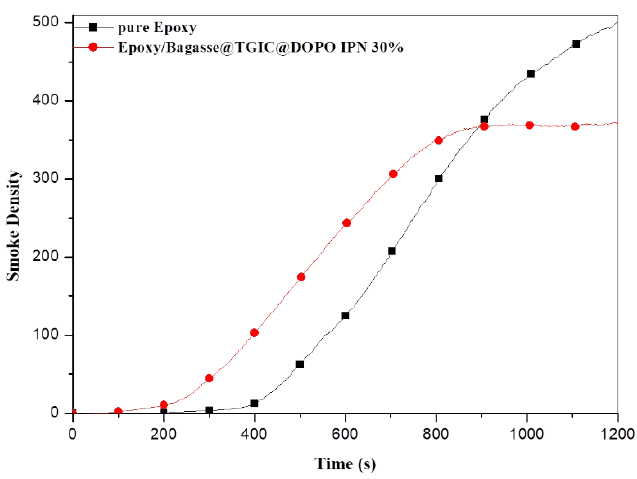
Figure 3. Smoke density curves of pure epoxy and Epoxy/Bagasse@TGIC@DOPO IPN 30% compo- sites.